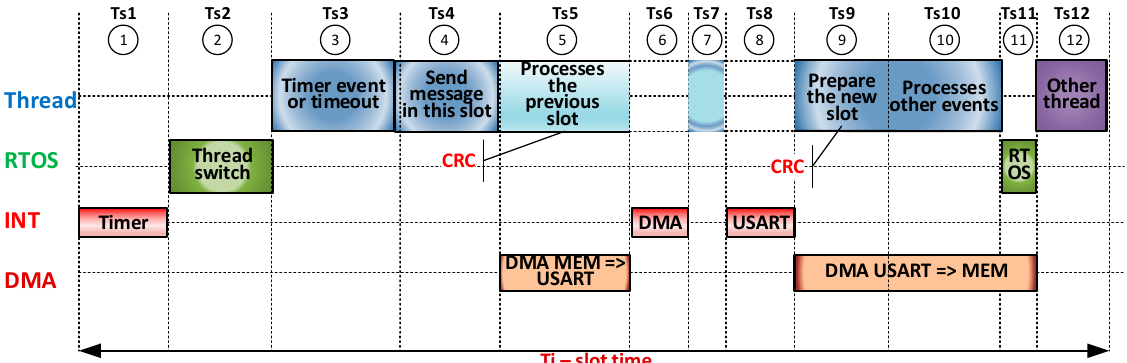
Figure 6. Pipeline SW (thread, RTOS, and ISR)/HW (DMA)—Scenario 1.